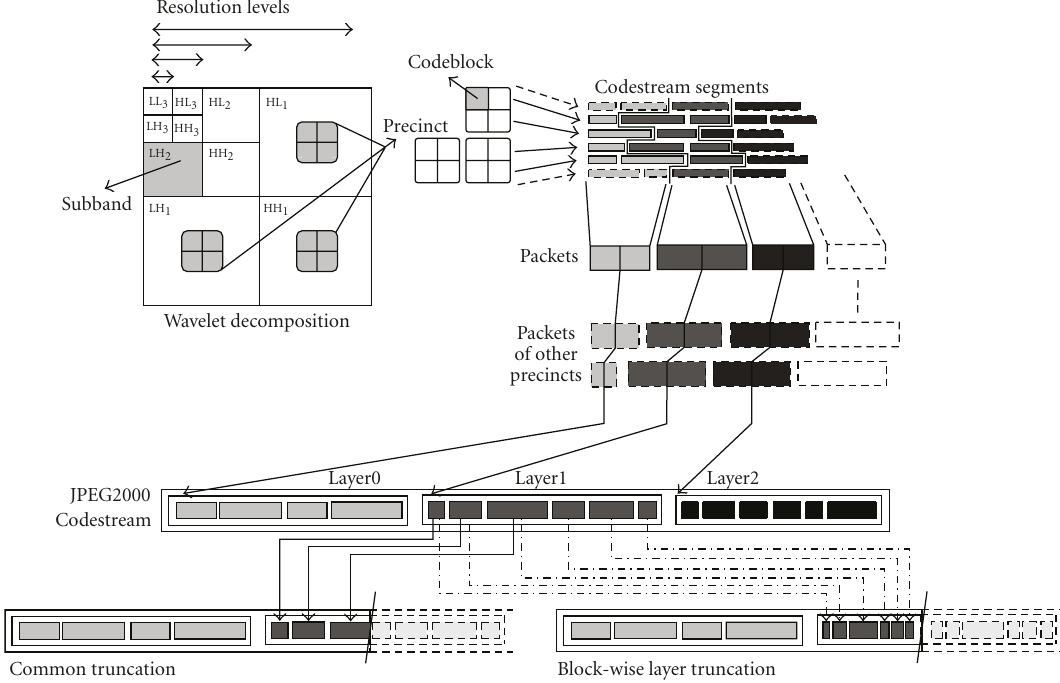
Figure 3: JPEG2000 partitioning system, and strategies of layer truncation.